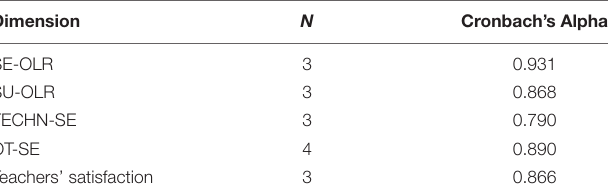
TABLE 3 | Reliability of the